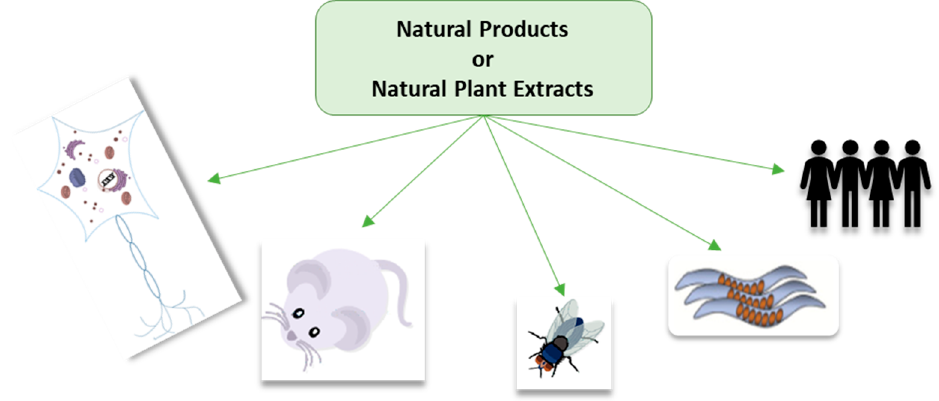
Figure 5. In vitro and in vivo models of neurodegenerative disease discussed in this review.